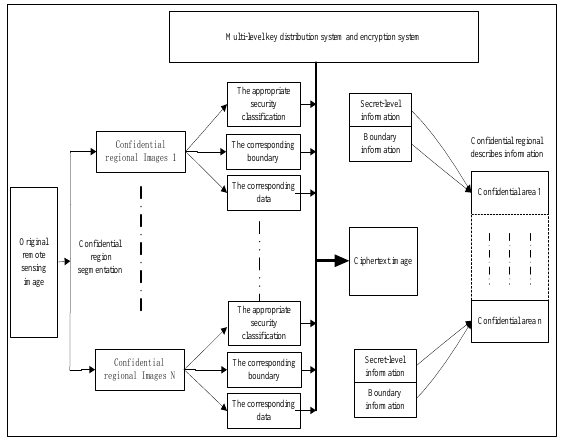
Figure 1. The framework of the Multilevel Security Authorization Method Based on Image Content After segmentation and extraction of the original image, we can get N secret images and 1 residual image. All the secrets of regional image